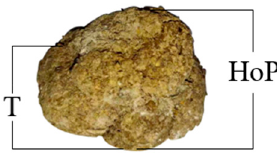
Figure 4. Pig manure external dimensions: HoP, T.